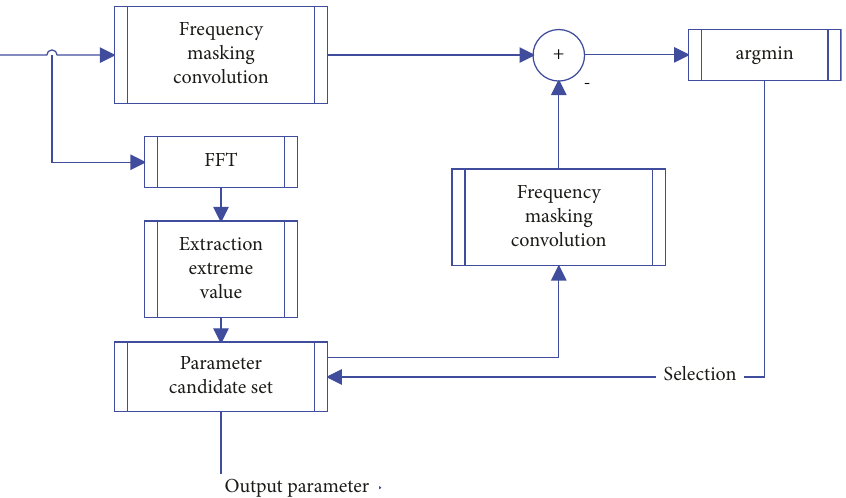
Figure 10: The frequency-domain parameter recursive selection algorithm used in this paper.